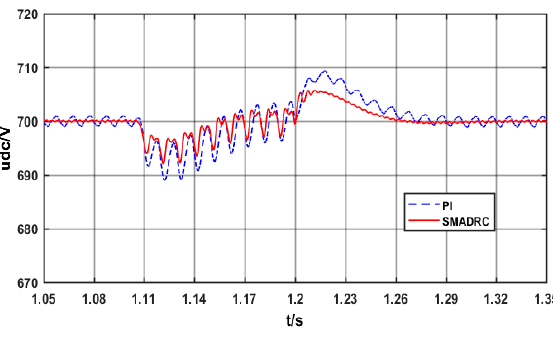
Figure 12. Three-phase voltage.